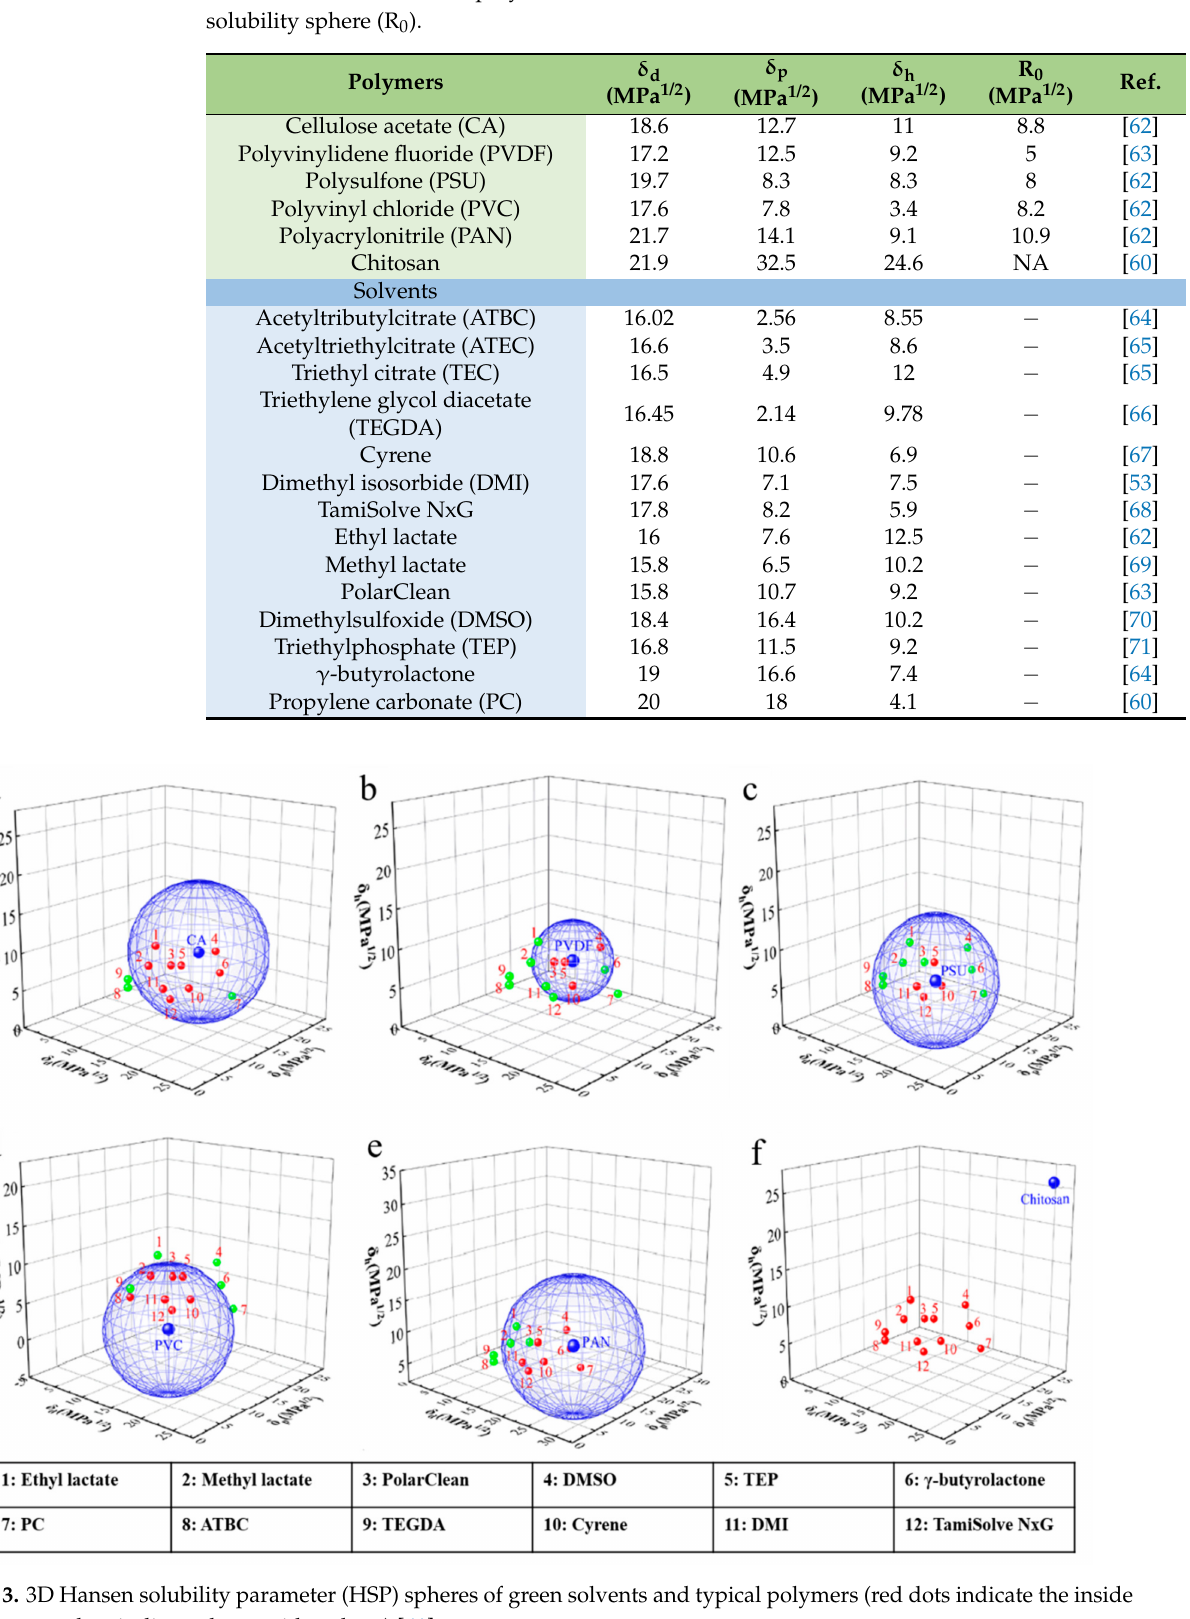
Figure 3. 3D Hansen solubility parameter (HSP) spheres of green solvents and typical polymers (red dots indicate the inside sphere, green dots indicate the outside sphere)